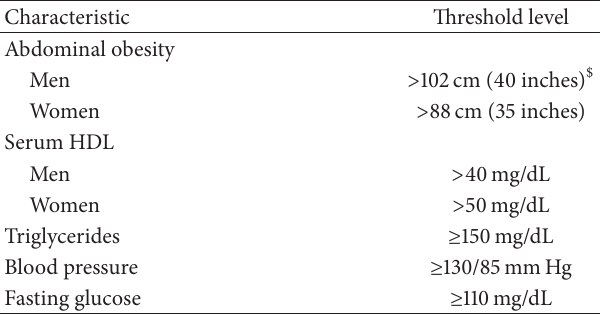
Table 1: Threshold levels to define metabolic syndrome